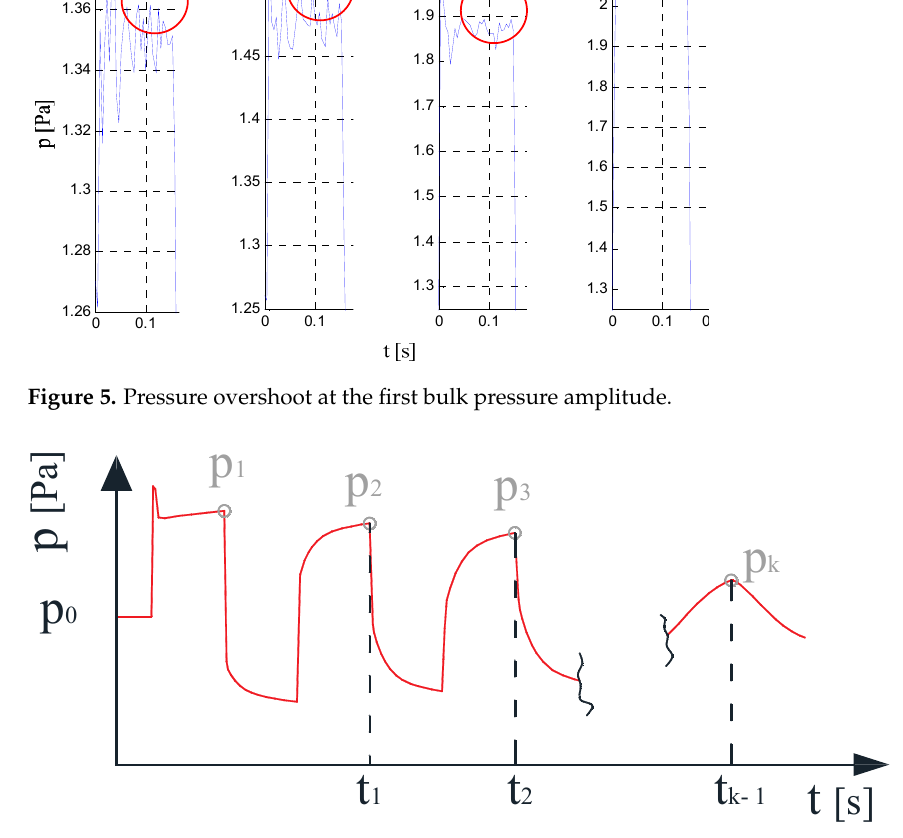
Figure 6. Analysed bulk pressure peaks in the quantitative comparison.